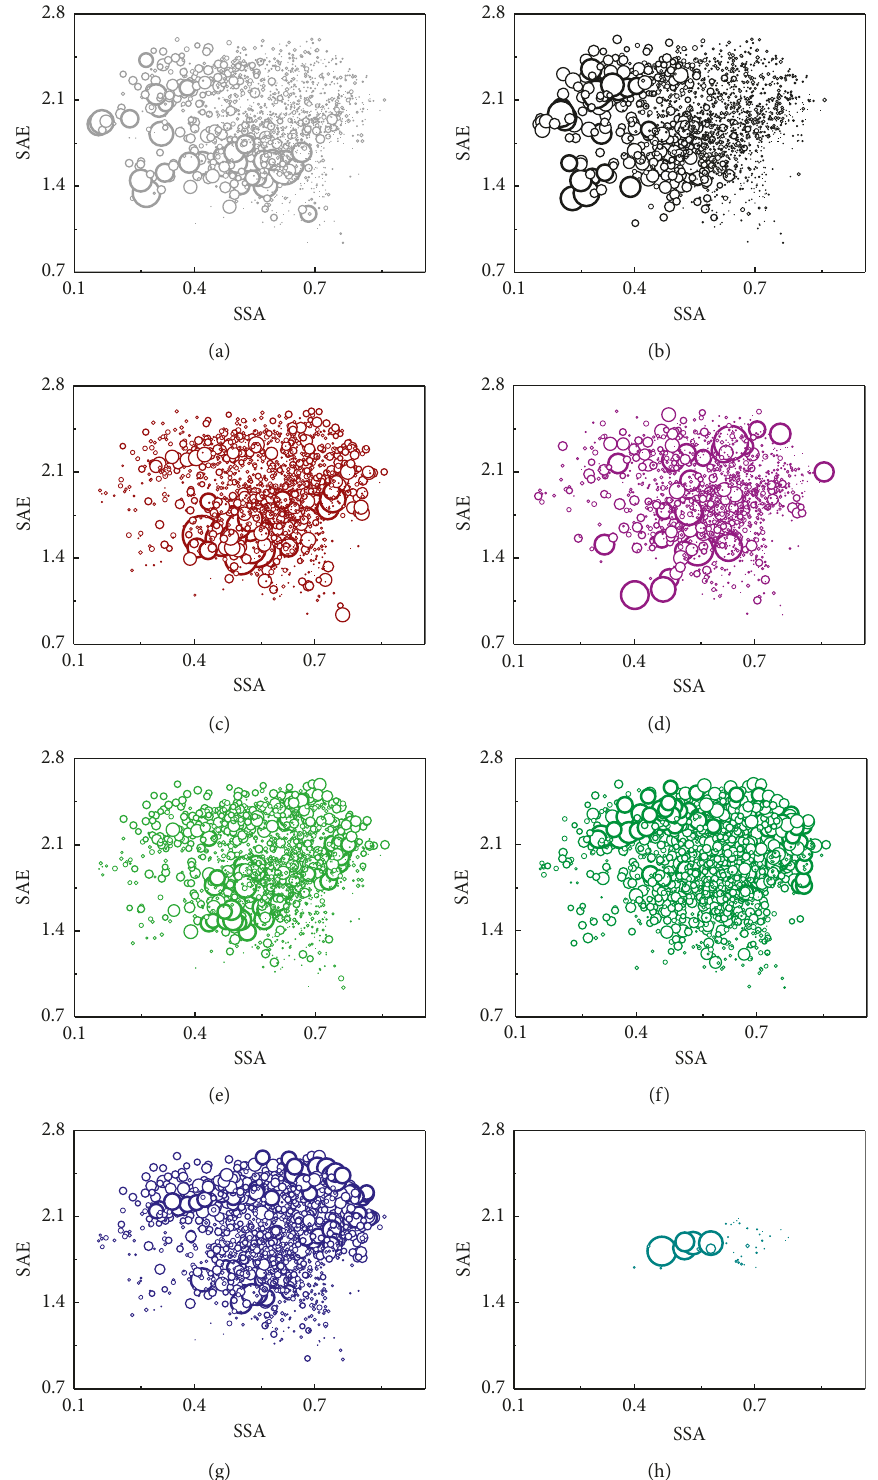
Figure 4: The SAE versus SSA plot with a size of data points of (a) HOA (grey), (b) BC tr (black), (c) BBOA (brown), (d) BC wb (purple), (e) SVOOA (light green), (f) LVOOA (dark green), (g) SIA (dark blue), and (h) LOA (light blue) for the entire measurement